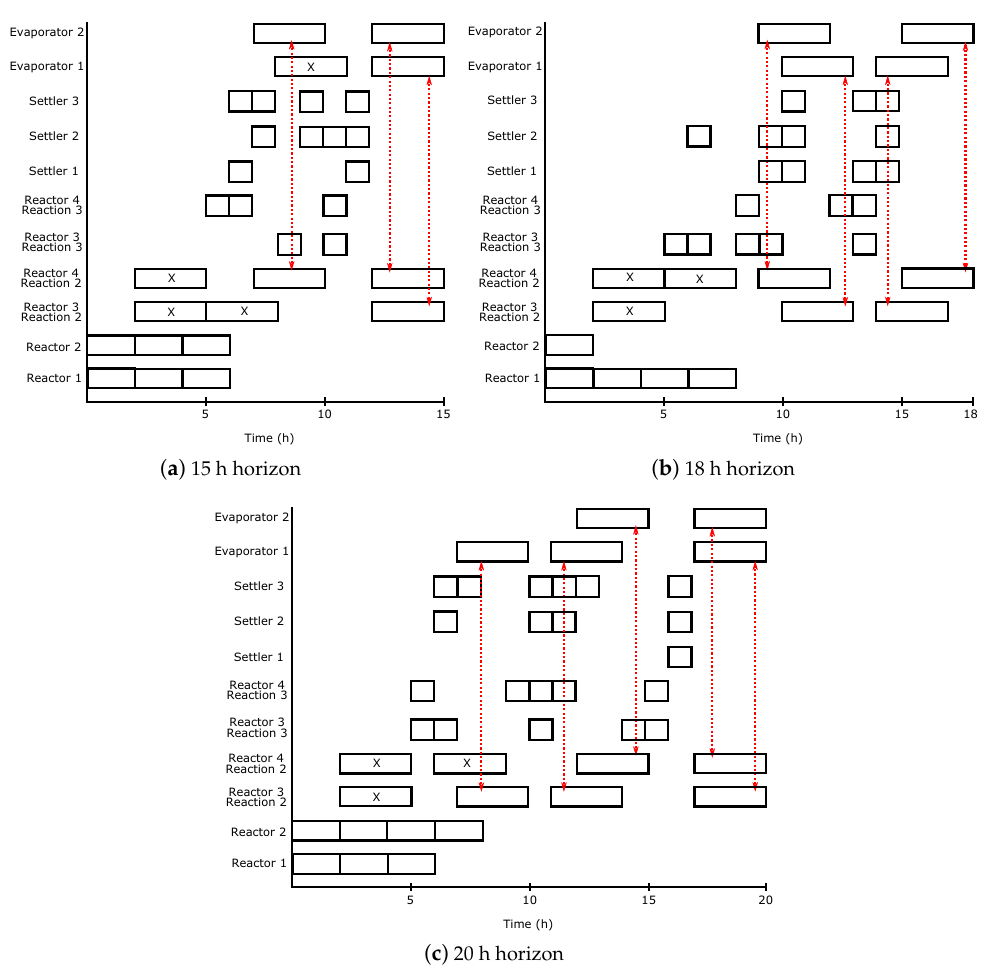
Figure 8. Optimal schedule for multipurpose industrial example( ←→ represents energy